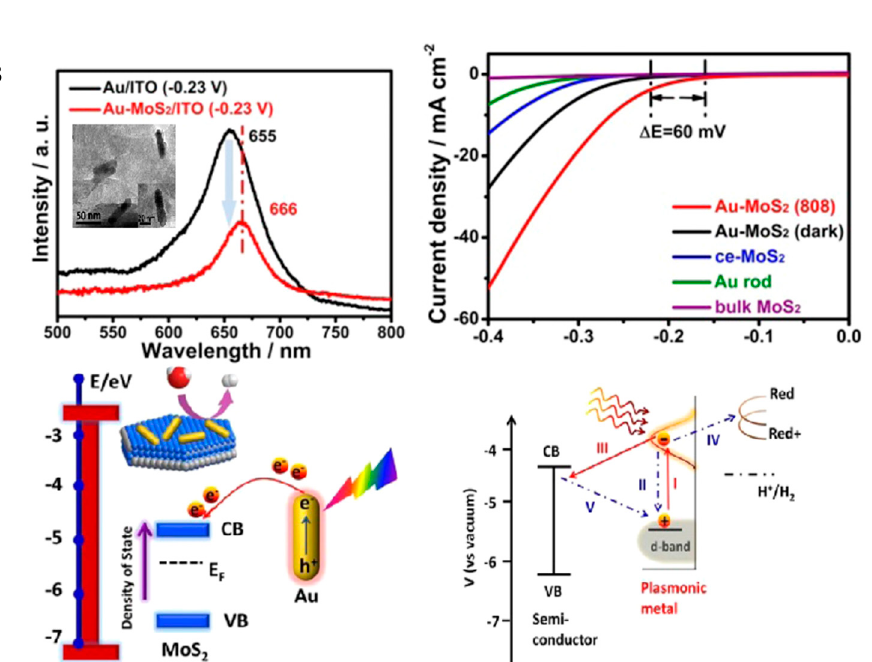
Figure 2. ( A ) ( a ) Localized surface plasmon resonance (LSPR) signal of gold nanoparticles (Au NPs) (inset TEM image) and cyclic voltammograms of glassy carbon (GC)/Au NPs in phosphate-buffered saline (PBS) (red) and in glucose (100 mM; black) as well as of GC in PBS (dark blue) together with mechanisms of direct plasmon-accelerated electrochemical reactions using the oxidation of glucose to gluconic acid as an example (reprinted with permission from Ref [4]); ( B ) LSPR spectra of Au rods in Au/Indium Tin Oxide(ITO) and Au − MoS 2 /ITO (inset: TEM image of Au–MoS 2 hybrids and Au NR); polarization curves recorded on Au, MoS 2 , and Au–MoS 2 hybrid (under illumination and dark) and energy level diagram (reprinted with permission from Ref [26]).